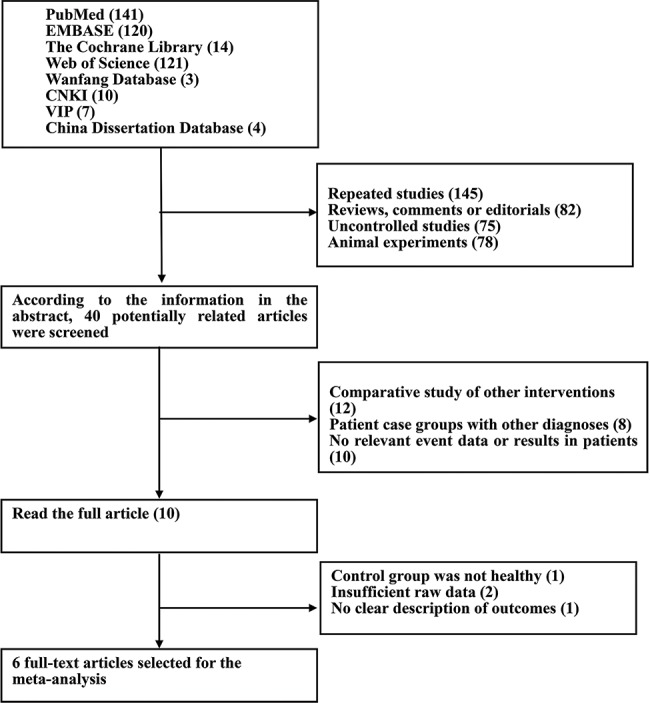
Flow chart of study selection based on the inclusion criteria.